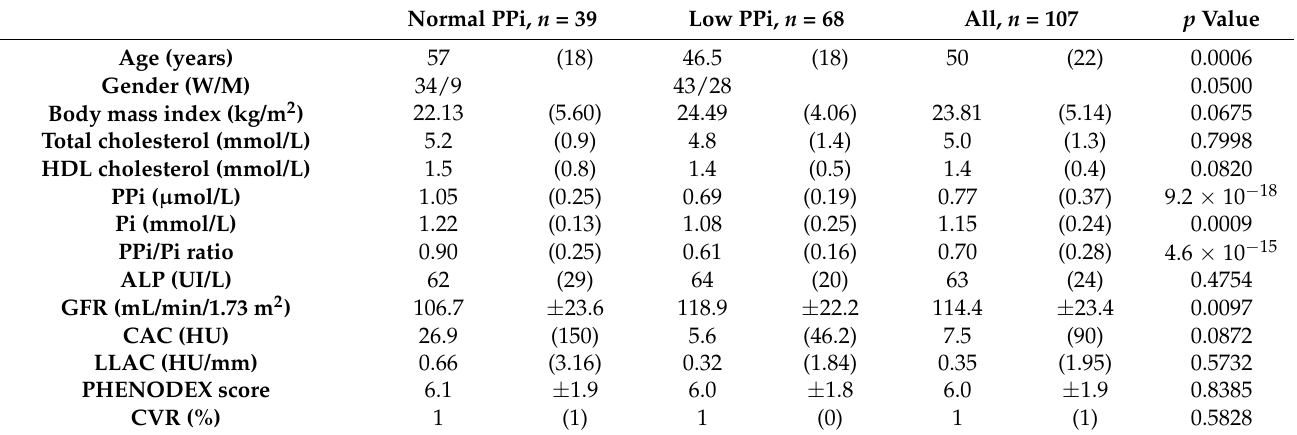
Table 2. Statistical comparisons between PXE patients exhibiting a significantly lower or a nonsignifi- cantly lower plasmatic PPi concentration (low or normal PPi) according to our laboratory reference control value for PPi. Data with a normal distribution are expressed as mean ( ± SD), others are expressed as median (interquartiles). PPi: inorganic pyrophosphate; Pi inorganic phosphate; ALP: alkaline phosphatase; GFR: glomerular filtration rate; CAC: Coronary arterial calcification; LLAC: Lower limb arterial calcification; CVR: 10 years—Cardiovascular Risk score.